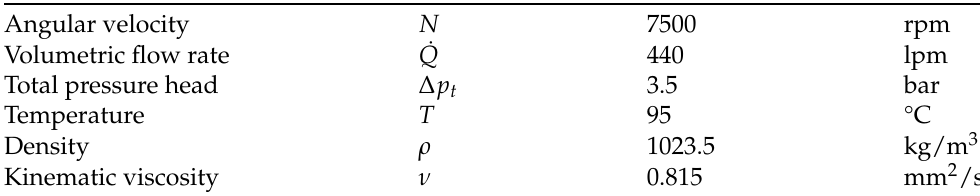
Table 1. Operating conditions for a centrifugal pump in the cooling circuit of a high performance gasoline car.